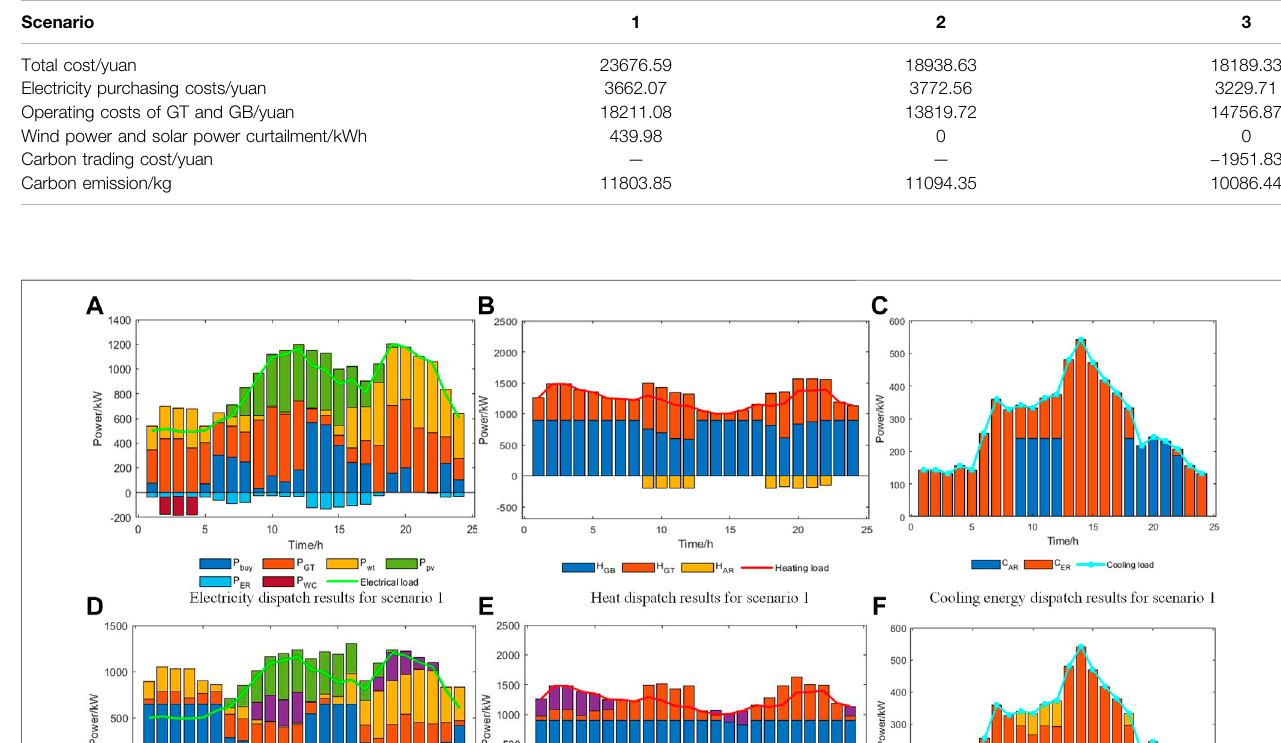
Frontiers in Energy Research |